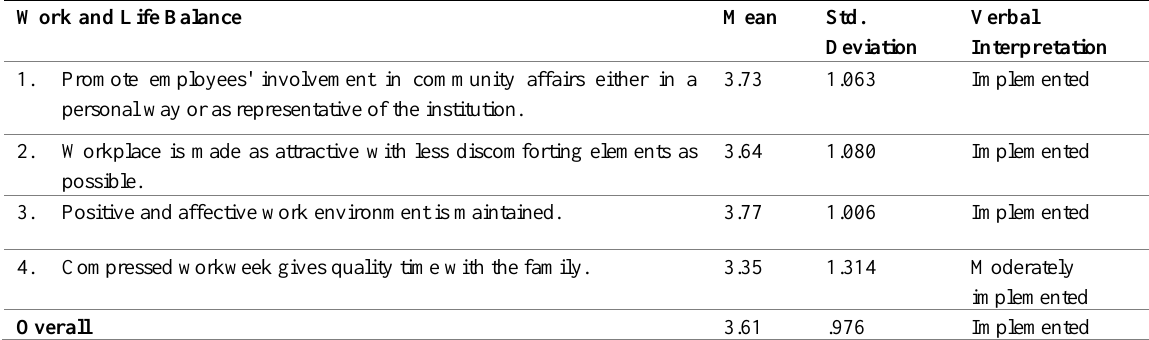
Table 12: The extent of implementation of excellence to work and life balance as perceived by respondents Work and Life Balance Mean Std.